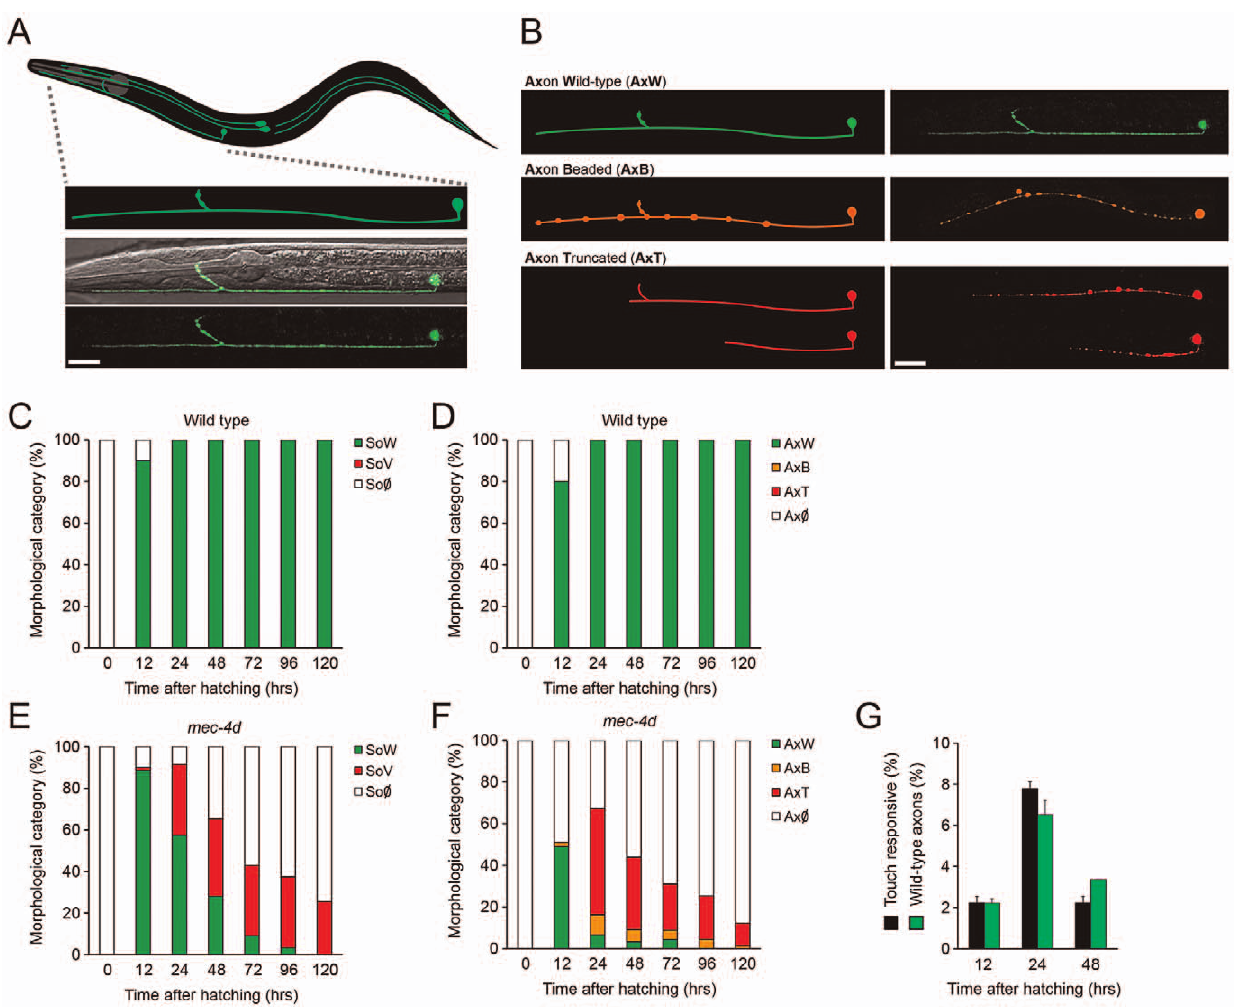
Figure 1. Functional and morphological time course of mec-4d mediated degeneration of C.elegans AVM neuron. (A) Schematic representation of the six mechanosensory neurons of an adult C. elegans with an expanded representation of the AVM neuron (anterior part of the worm is to the left) and below a confocal image of the AVM expressing gfp under a touch neuron specific promoter ( P mec-17 mec-17::gfp ) in a wild type (N2) background merged with a Nomarski optic micrograph. Only the anterior portion is shown. Scale bar, 25 m m. (B) Morphological categories of the AVM axon in a wild type condition and during the progression of degeneration triggered by the expression of the MEC-4d degenerin channel. Schematic representations of the different axonal morphological categories are shown in the left panel, the right panel shows neurons as seen by confocal microscopy. GFP-expressing neurons have been pseudo-colored to match the morphological categories. Scale bar, 25 m m. (C–F) Temporal analysis of morphological categories from the time of hatching for AVM somas and axons in wild-type (C–D), and mec-4d mutants (E–F). (C) AVM somas in the wild type strain ( P mec-17 mec-17::gfp ) are almost fully present at 12 hours. (D) AVM axons are still growing at 12 hours but at 24 hours they have reached their full extension. (E) AVM somas in mec-4d mutants appear by 12 hours and therein steadily degenerate, going through a vacuolated stage. (F) AVM axons in mec-4d mutants appear and extend along the anterior region at 12 hours and thereafter they degenerate through beaded and then truncated intermediate stages (mean value for each category is shown; error bars [ , 0.1%] are not included; N=3 of 30 worms each per group). (G) Anterior touch response (black bars) and percentage of morphologically wild-type axons (green bars) of mec-4d worms at 12, 24 and 48 hours post hatching. For the 12-hour time point of this graph, only AVM neurons with fully-grown axons were considered as wild-type (mean values are shown; error bars indicates SEM; N=3 of 30 worms each per group). SoW: soma wild type; SoV: Soma vacuolated; So : soma absent; AxW: Axon wild type; AxB: Axon beaded; AxT: Axon truncated; Ax : Axon